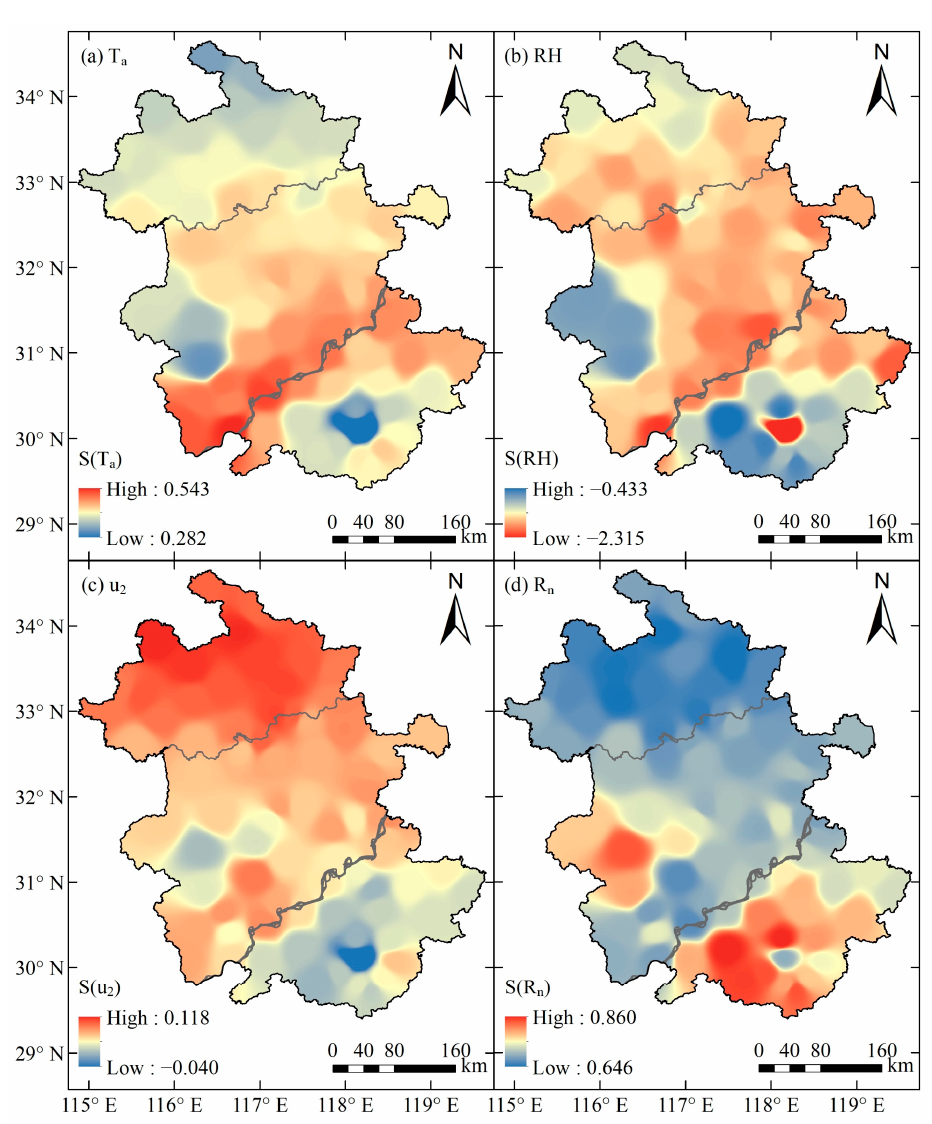
Figure 7. Space distribution of annual mean sensitivity coefficient of ET 0 to meteorological factors ( a ) T a , ( b ) RH, ( c ) u 2 , ( d ) R n .